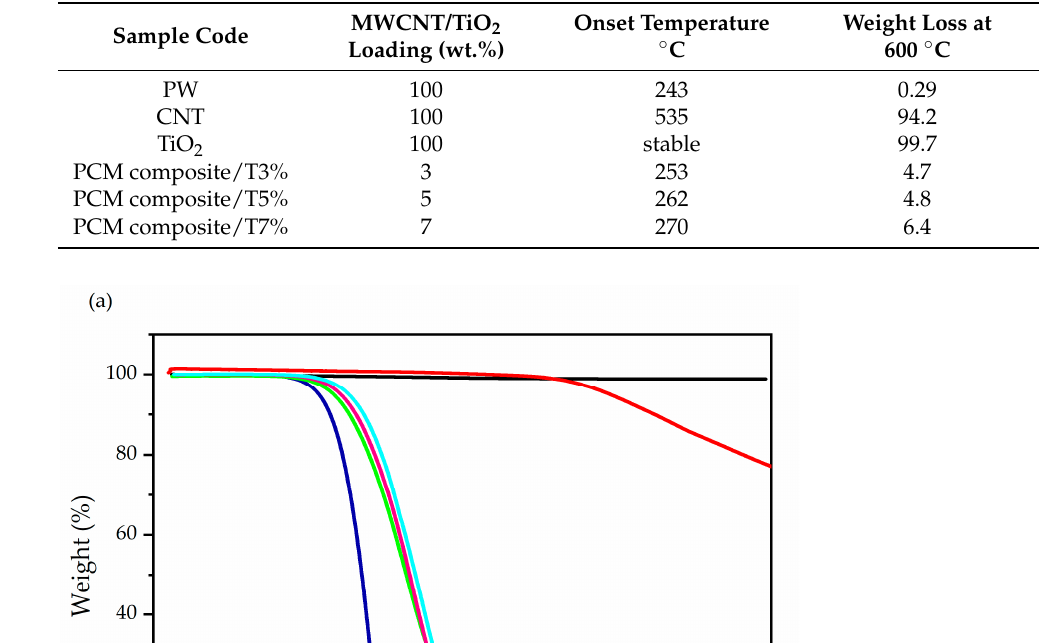
Table 4. TGA data of the PW and various composites.